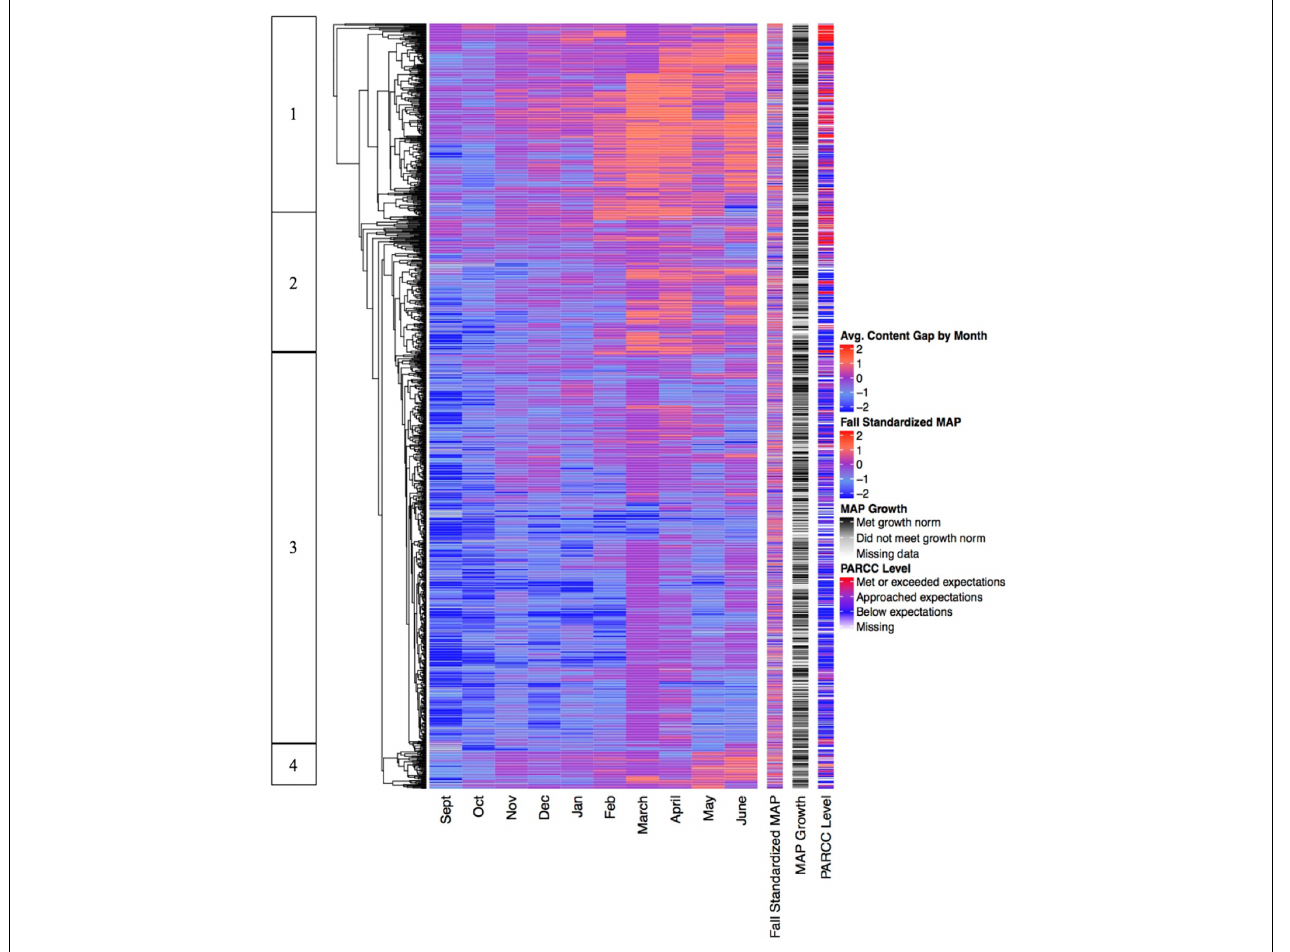
FIGURE 7 | Content gap displayed longitudinally with monthly